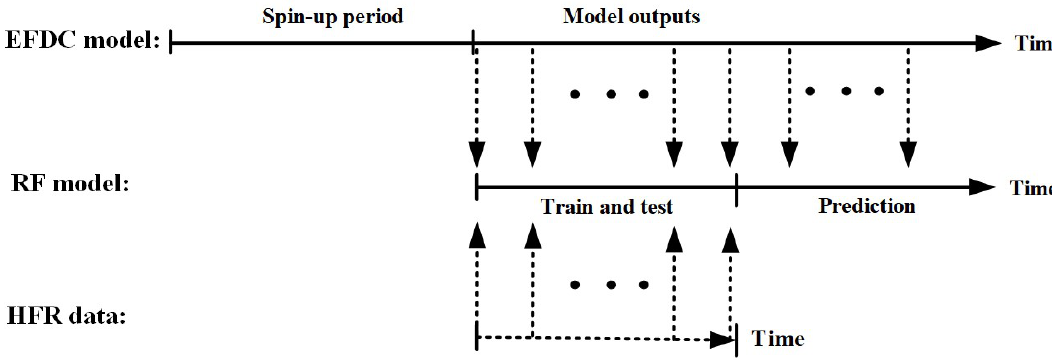
Figure 2. Schematic of the proposed prediction method.